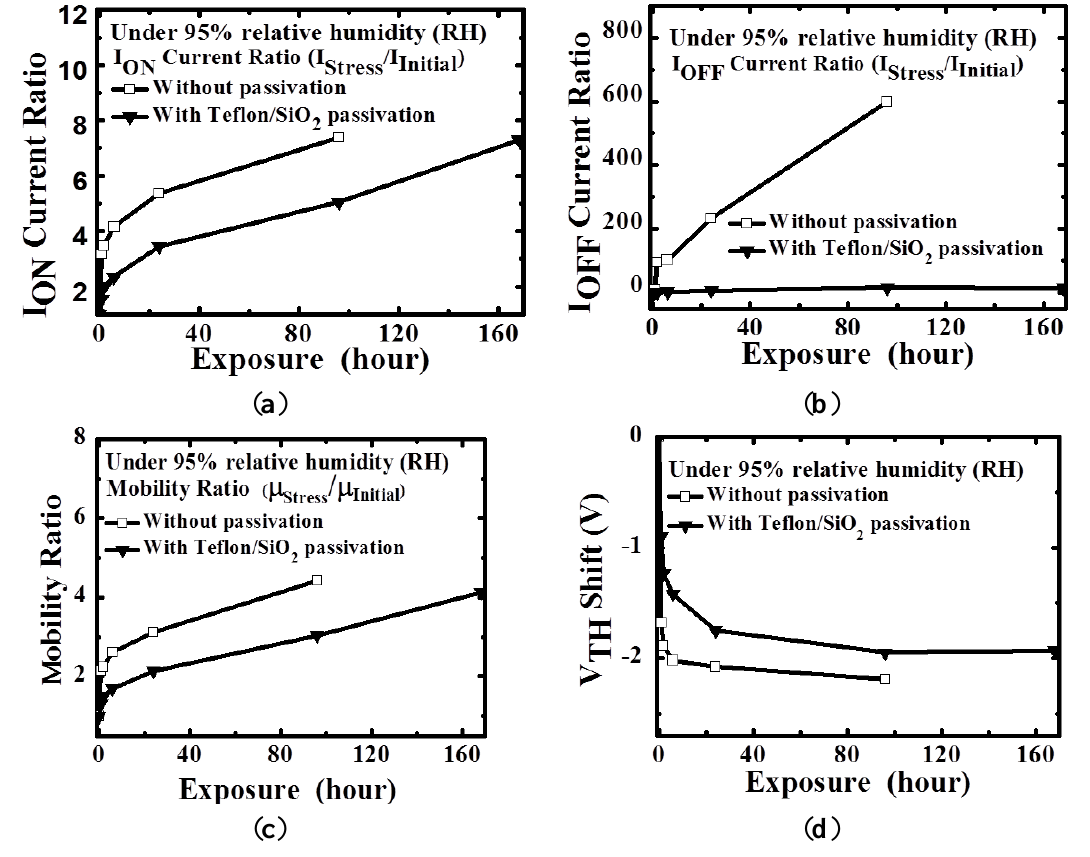
Figure 4. Time-dependent changes in the ( a ) I ON ; ( b ) I OFF ; ( c ) μ FE ; and ( d ) V TH of a-IGZO TFTs with and without Teflon/SiO 2 passivation in a 95% relative humidity environment, respectively.